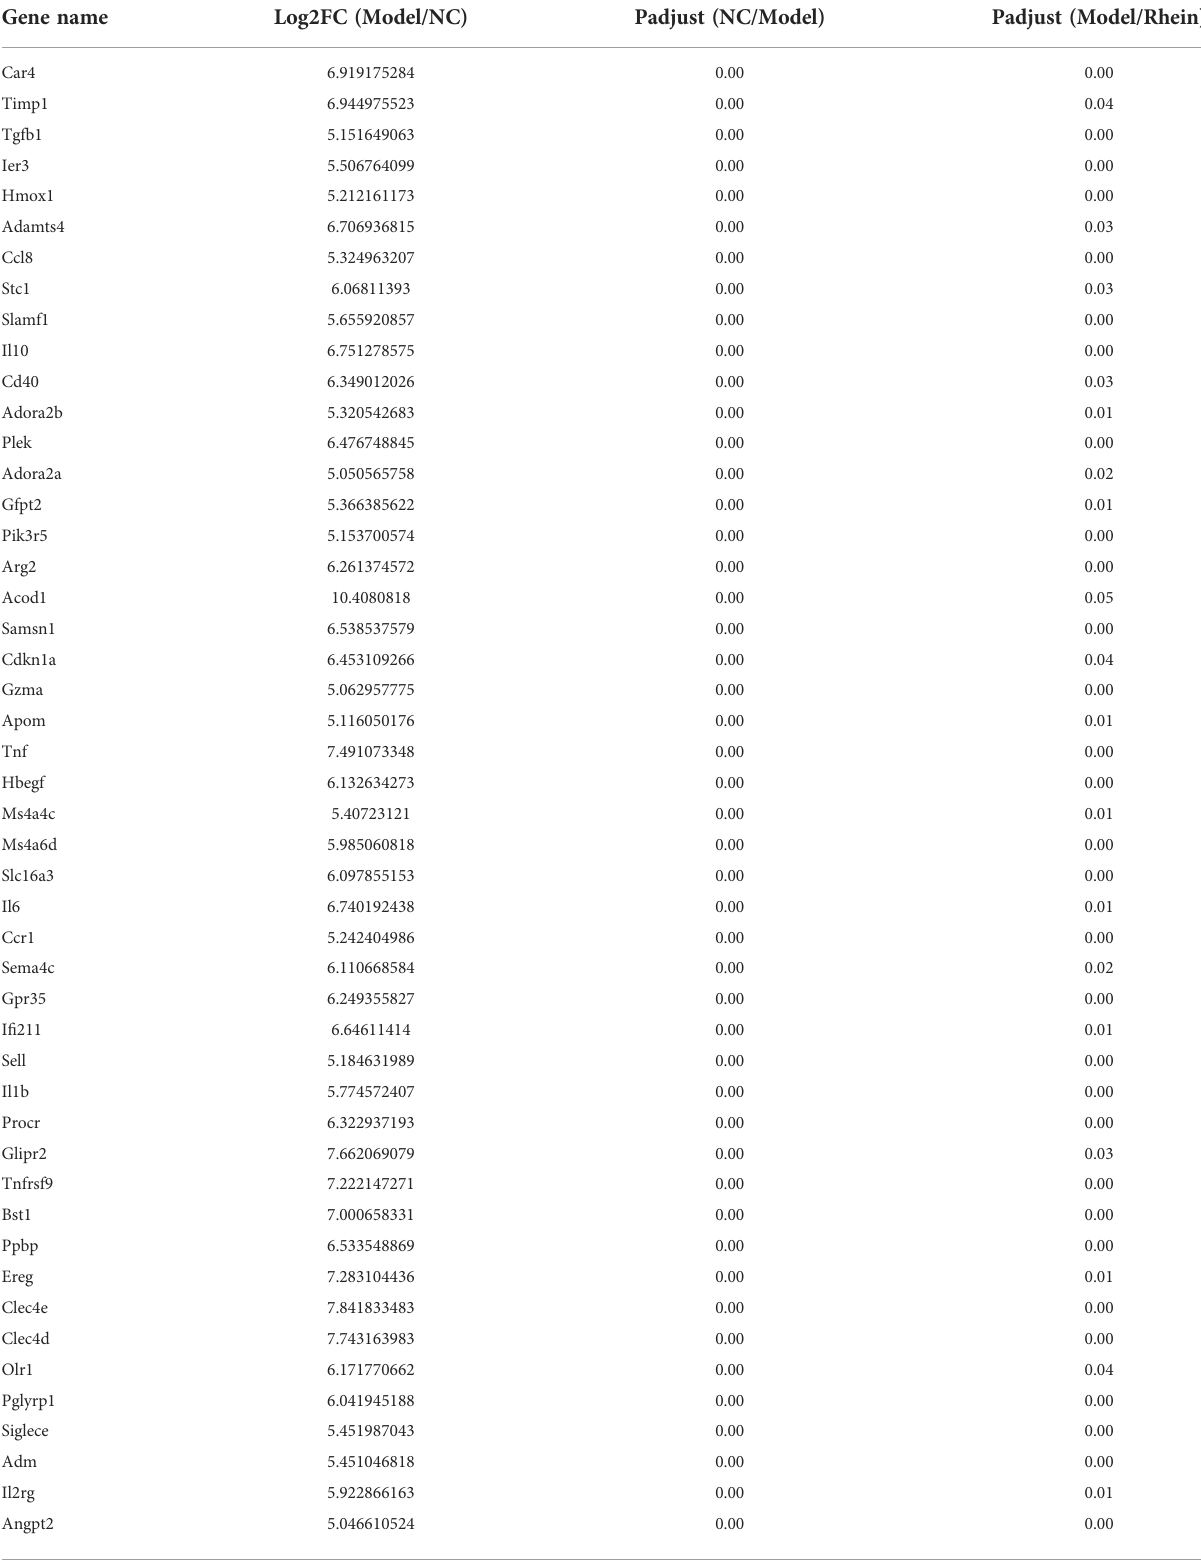
TABLE 2 Signi fi cantly up-regulated genes (-5<Log2FC<5, Padjust<0.05) upon exposure of D-DalN/LPS compared to the control